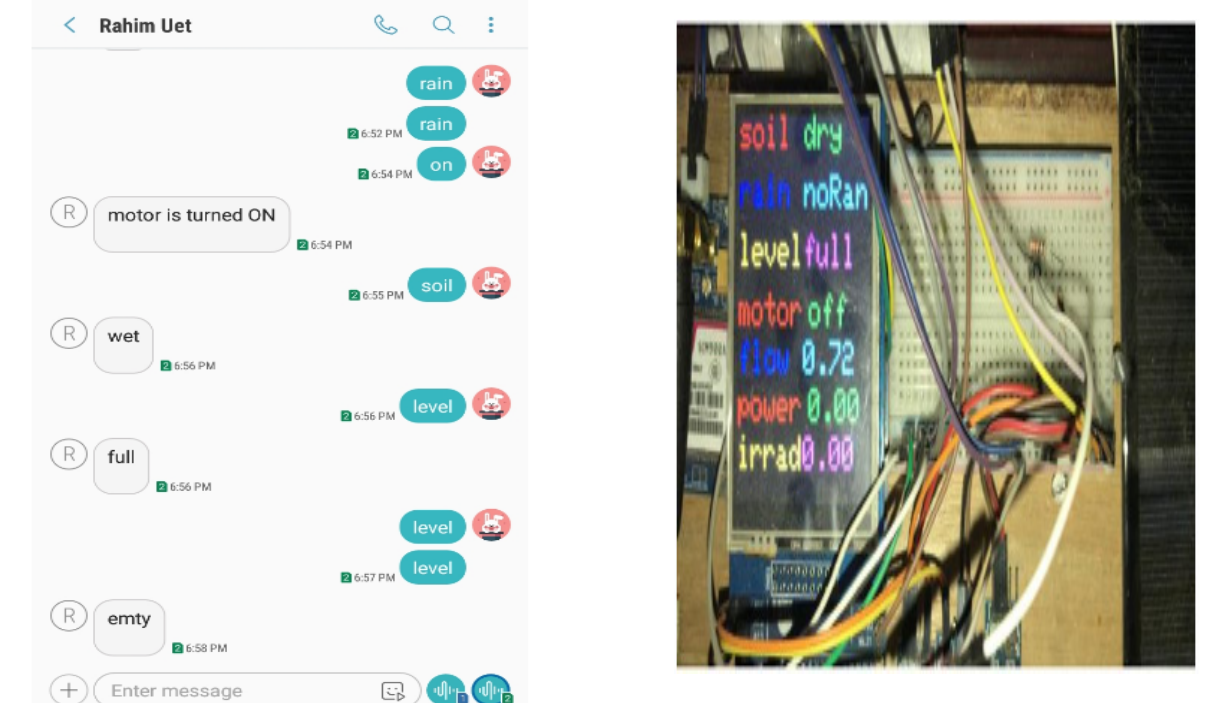
Figure 12. Hardware results of proposed system for validation.